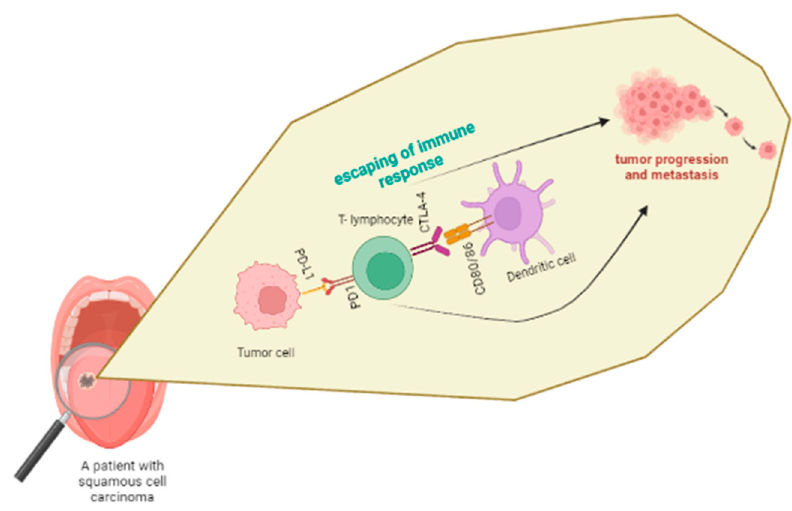
Figure 2. Escaping head-and-neck tumors from immune response .